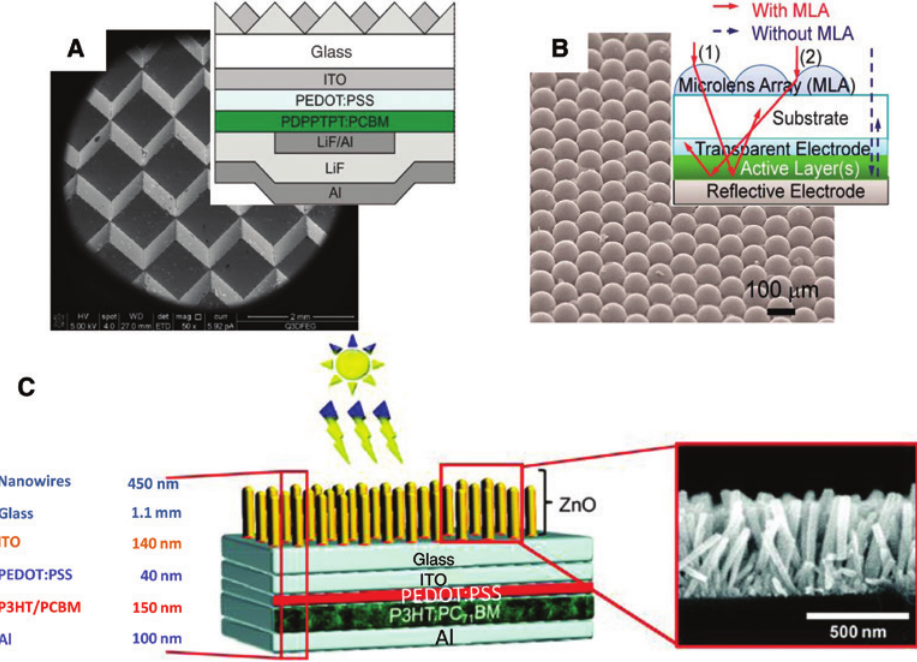
Figure 6: Nanostructures improve light incidence. (A) SEM image of the retroreflective light-trapping texture, and inset shows the device structure (reprint with permission Ref. [81]; Copyright 2013 Wiley-VCH Verlag GmbH & Co. KGaA, Weinheim). (B) SEM image of microlens array, and inset shows the schematic illustration of light trapping with the microlens array (reprint with permission Ref. [86]; Copyright 2012 The Royal Society of Chemistry). (C) Structure of OPVs with ZnO NWs, and SEM image of ZnO NWs (reprint with permission Ref. [87]; Copyright 2014 The Royal Society of